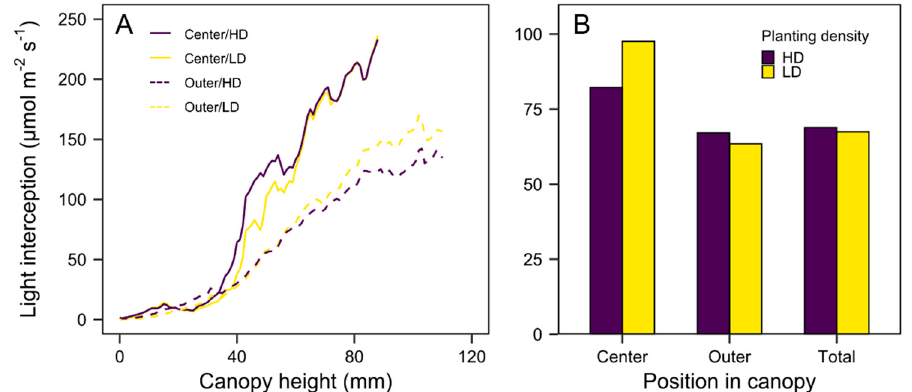
Figure 7. Simulation results of vertical light interception at different planting densities and canopy positions ( A ) and the averaged light interception of lettuce plants according to position in the canopy ( B ). The canopy was divided into one plant in the center and eight outer plants. HD and LD indicate high planting density (25 plants m − 2 ) and low planting density (16 plants m − 2 ), respectively.